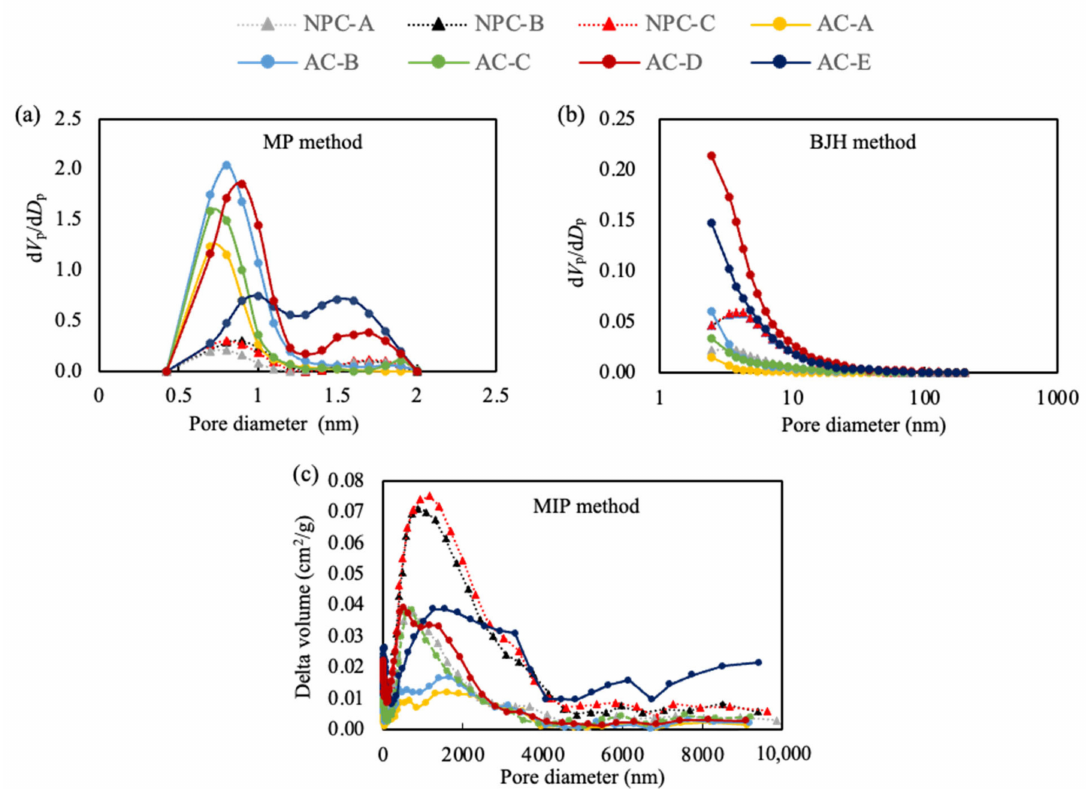
Figure 2. The pore size distribution of different porous carbon adsorbents measured by the MP ( a ), BJH ( b ), and MIP ( c ) methods. Vp and Dp represent the pore volume (cm 3 ) and pore diameter (nm),